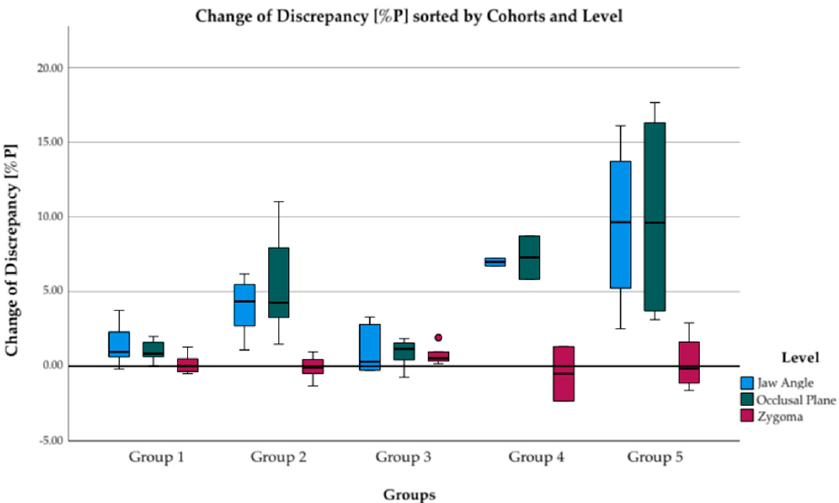
Figure 12. Boxplots displaying change of discrepancy in percentage points subdivided into groups 1–5. Positive values are improvements in symmetry, while negative values mean a deterioration in symmetry. Improvements occur at the levels of jaw angle (blue) and occlusal plane (green). However, there are no changes in the discrepancy at the level of zygoma (red) in any of the